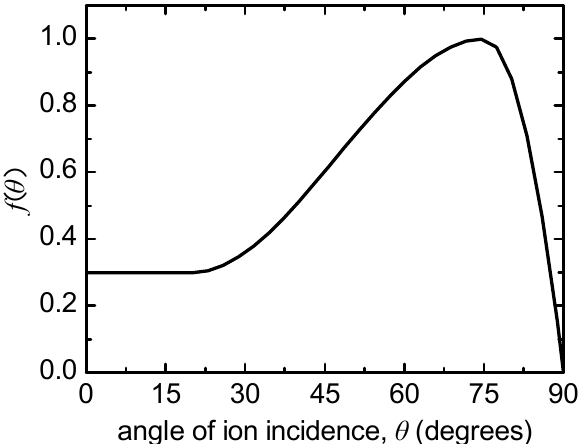
Figure 3. The function f ( θ ) of Equation (4) vs. the angle of ion incidence, θ . The maximum is at 75°.